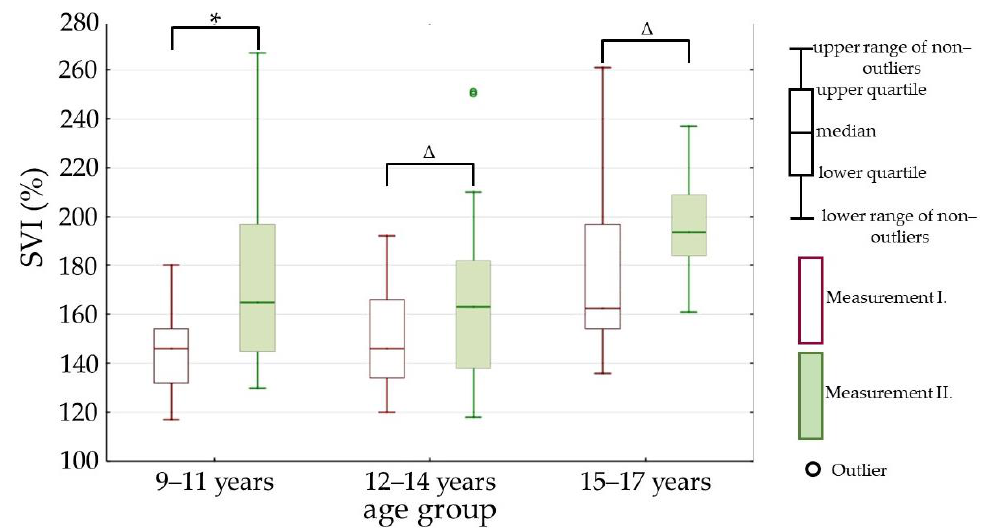
Figure 6. Subendocardial viability index (SVI) in measurements I. and II. Measurement I.—at the beginning of the one-month stay in the children’s hospital; measurement II.—at the end of the one-month stay in the children’s hospital; *— p value is less than 0.01; ∆ — p value is less than 0.05; p value—statistical evaluation of the differences between the measurements I. and II., Wilcoxon signed-rank test (paired test).